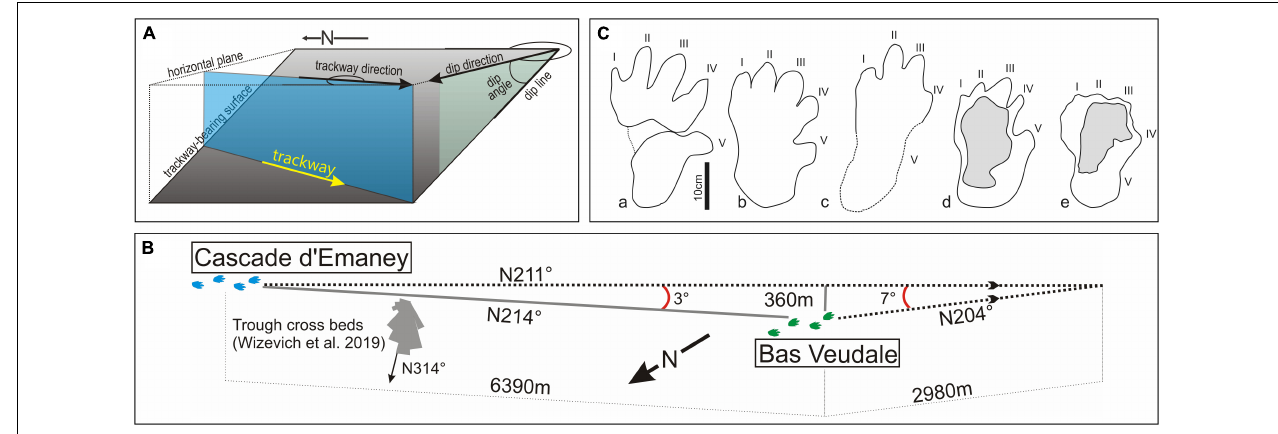
FIGURE 3 | Trackways geometrical settings and morphology of the footprints. (A) Measurement of the trackway and dip direction; (B) geometry of trackways; (C) outlines of I. herculis pes from various localities. a, Lower Triassic (Olenekian) of Germany (redrawn from Klein and Haubold, 2003, Figure 2o); b, Lower Triassic (Aegean) of Germany (redrawn from Diedrich, 2012, Figure 6c); c, Cascade d’Emaney outcrop (bar 7b, this work); d, Bas Veudale outcrop (Bas-Veu 1d, this work); e, Haut Veudale outcrop (redrawn from Klein et al., 2016, Figure